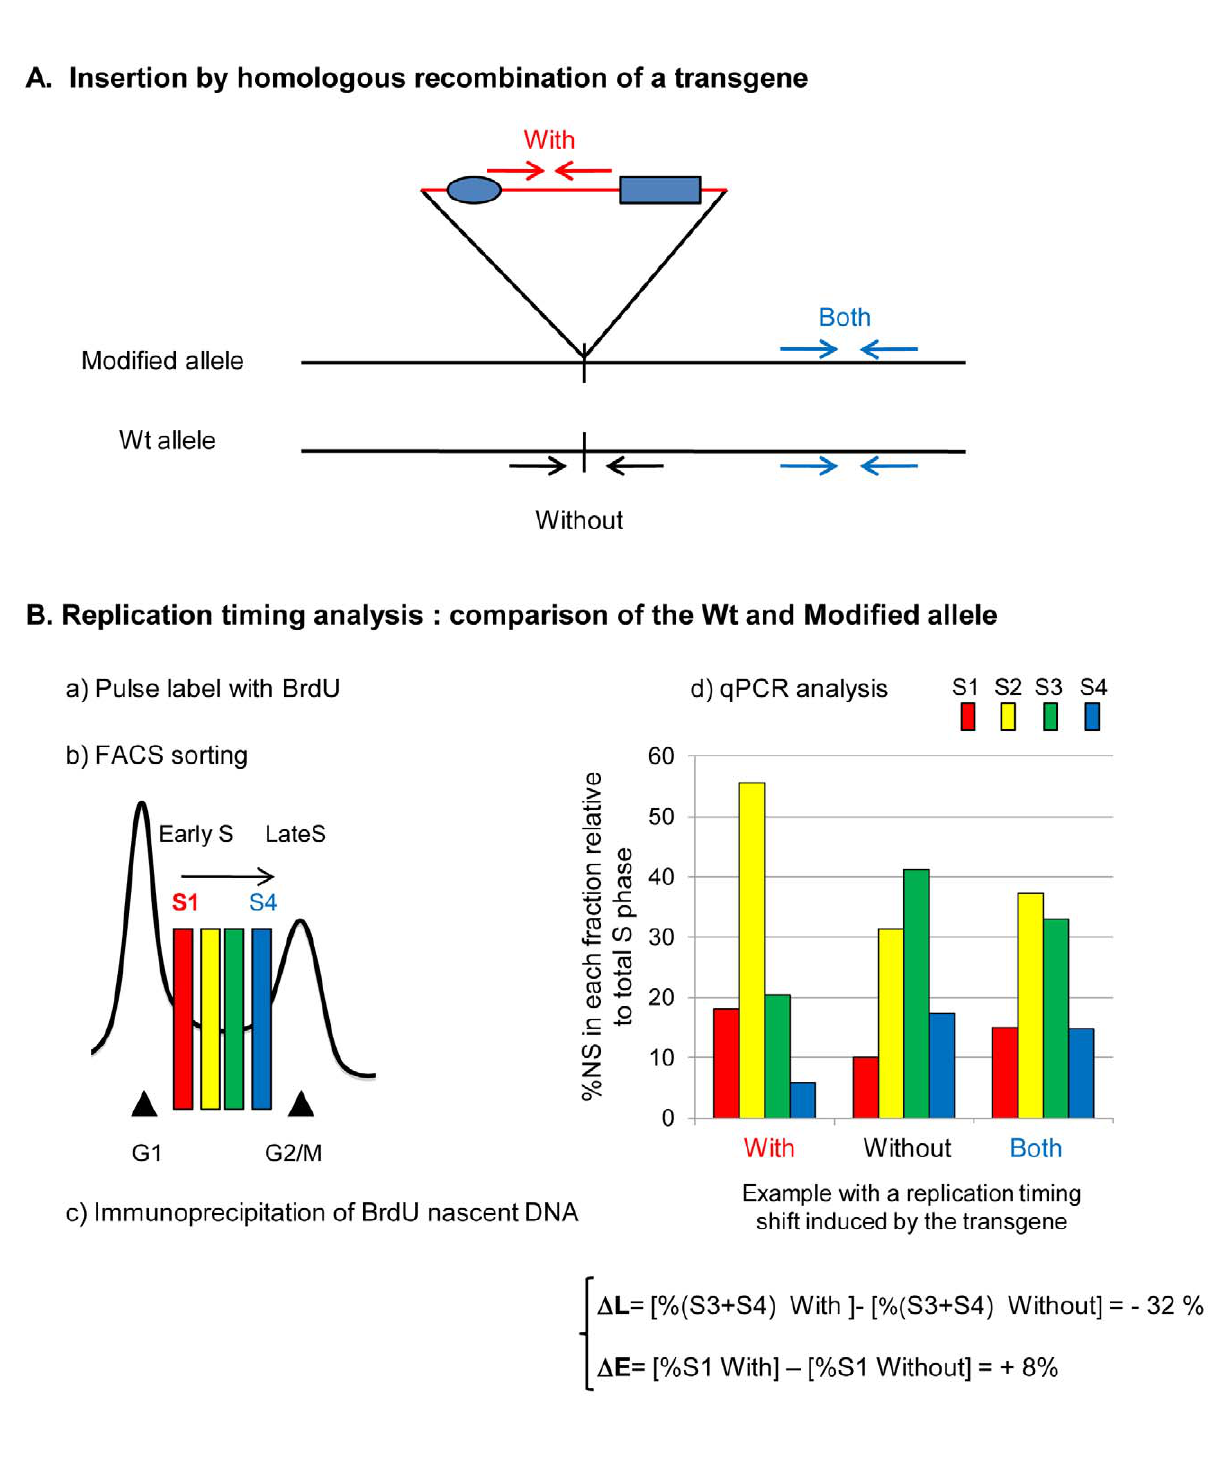
Figure 3. Analysis of replication timing changes after the insertion of cis -regulatory elements. (A) Diagram showing the modified allele after insertion of a transgene by homologous recombination and below the wild type allele. Primer pairs used for replication timing analyses are shown and can detect replication timing of the modified allele (With), the wild type allele (Without), or both alleles (Both). (B) After insertion by homologous recombination, selected clones are pulse labeled with BrdU and cell sorted into four fractions from early to late S-phase. BrdU labeled nascent strand DNA is immunoprecipitated and quantified by real-time PCR. The nascent strands produced at the site of integration on the allele containing the transgene (With), the wild type allele (Without), or both alleles (Both) were quantified. Analyses of both alleles should display an average picture of the profiles obtained on each allele, thus providing a validation of the PCR quantification. For each clone, we calculate differences in the timing of replication between the unmodified (Without) and targeted (With) alleles, where D L and D E describe the differences in late and early S-phase, respectively.